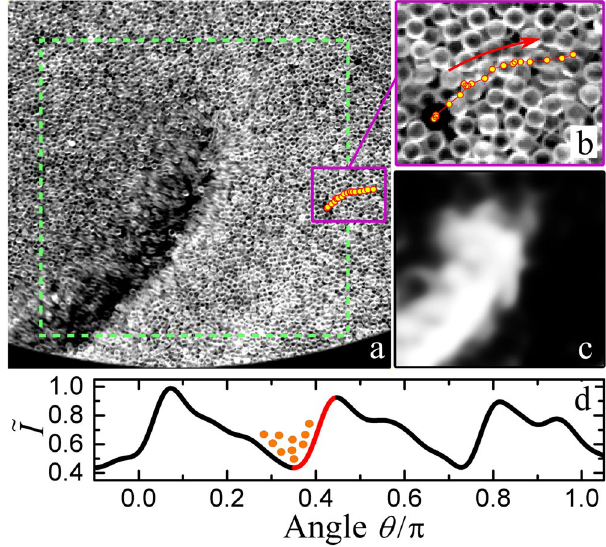
Figure 4. ( a ) A close view of a DWF propagating in the clockwise direction with the positions of a tracer particle in the following three vibration cycles marked with yellow dots (uncertainty ~0.1 d ). The snapshot is captured directly after the granular layer collides with the container bottom. ( b ) A zoom-in view of the tracer trajectory with the migration direction marked with a red arrow. The images are captured with seven frames per vibration cycle and an exposure time of 2 ms. ( c ) Spatially resolved covariance between ( a ) and its subsequent frame. It corresponds to the center region of ( a ), as marked by the dashed square. The brightness corresponds to the mobility of the particles averaged over a region of d × d . ( d ) A normalized intensity profile for illustrating the front propagation mechanism (see text for details). One of the six DWFs is highlighted in red. Other parameters are the same as in Fig.